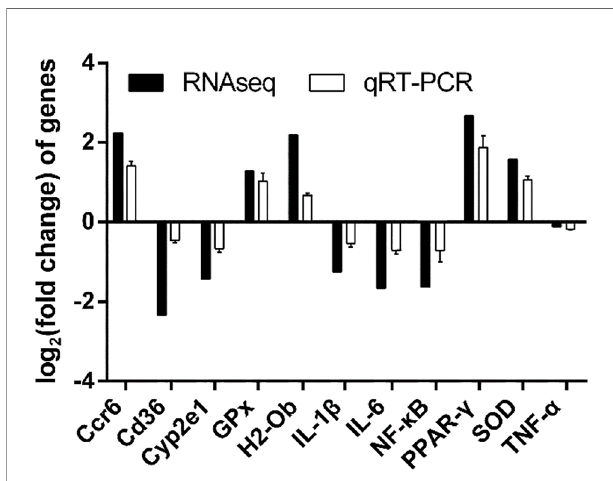
FIGURE 6 | Comparison of DEGs and qRT-PCR con fi